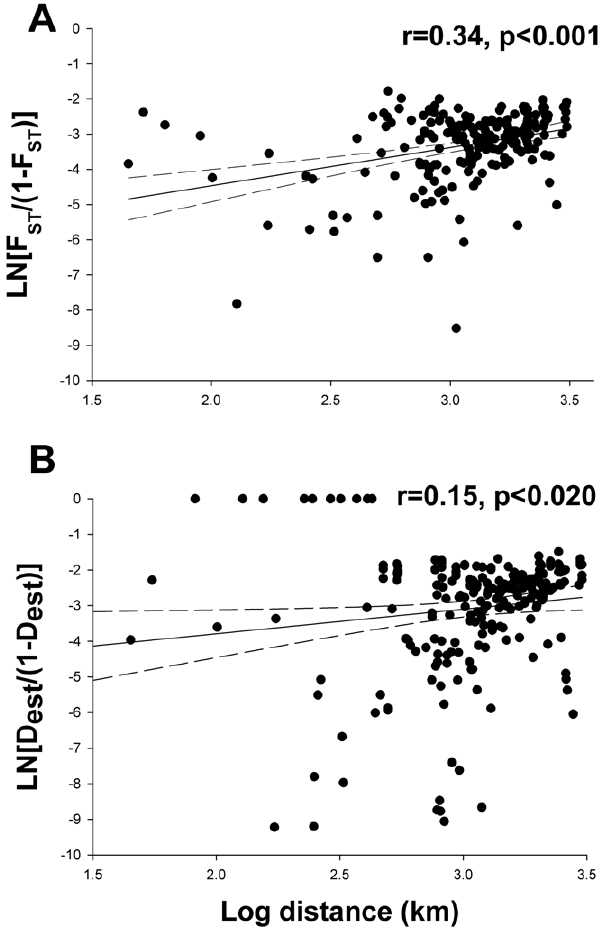
Figure 5. Relationship between pairwise F ST -values and the geographical distances for the 22 I.elegans populations. Test of isolation-by-distance: r=0.34 and p , 0.001. B) Relationship between pairwise D est -values and the geographical distances for the 22 I. elegans populations. Test of isolation-by-distance: r=0.15 and p , 0.020.